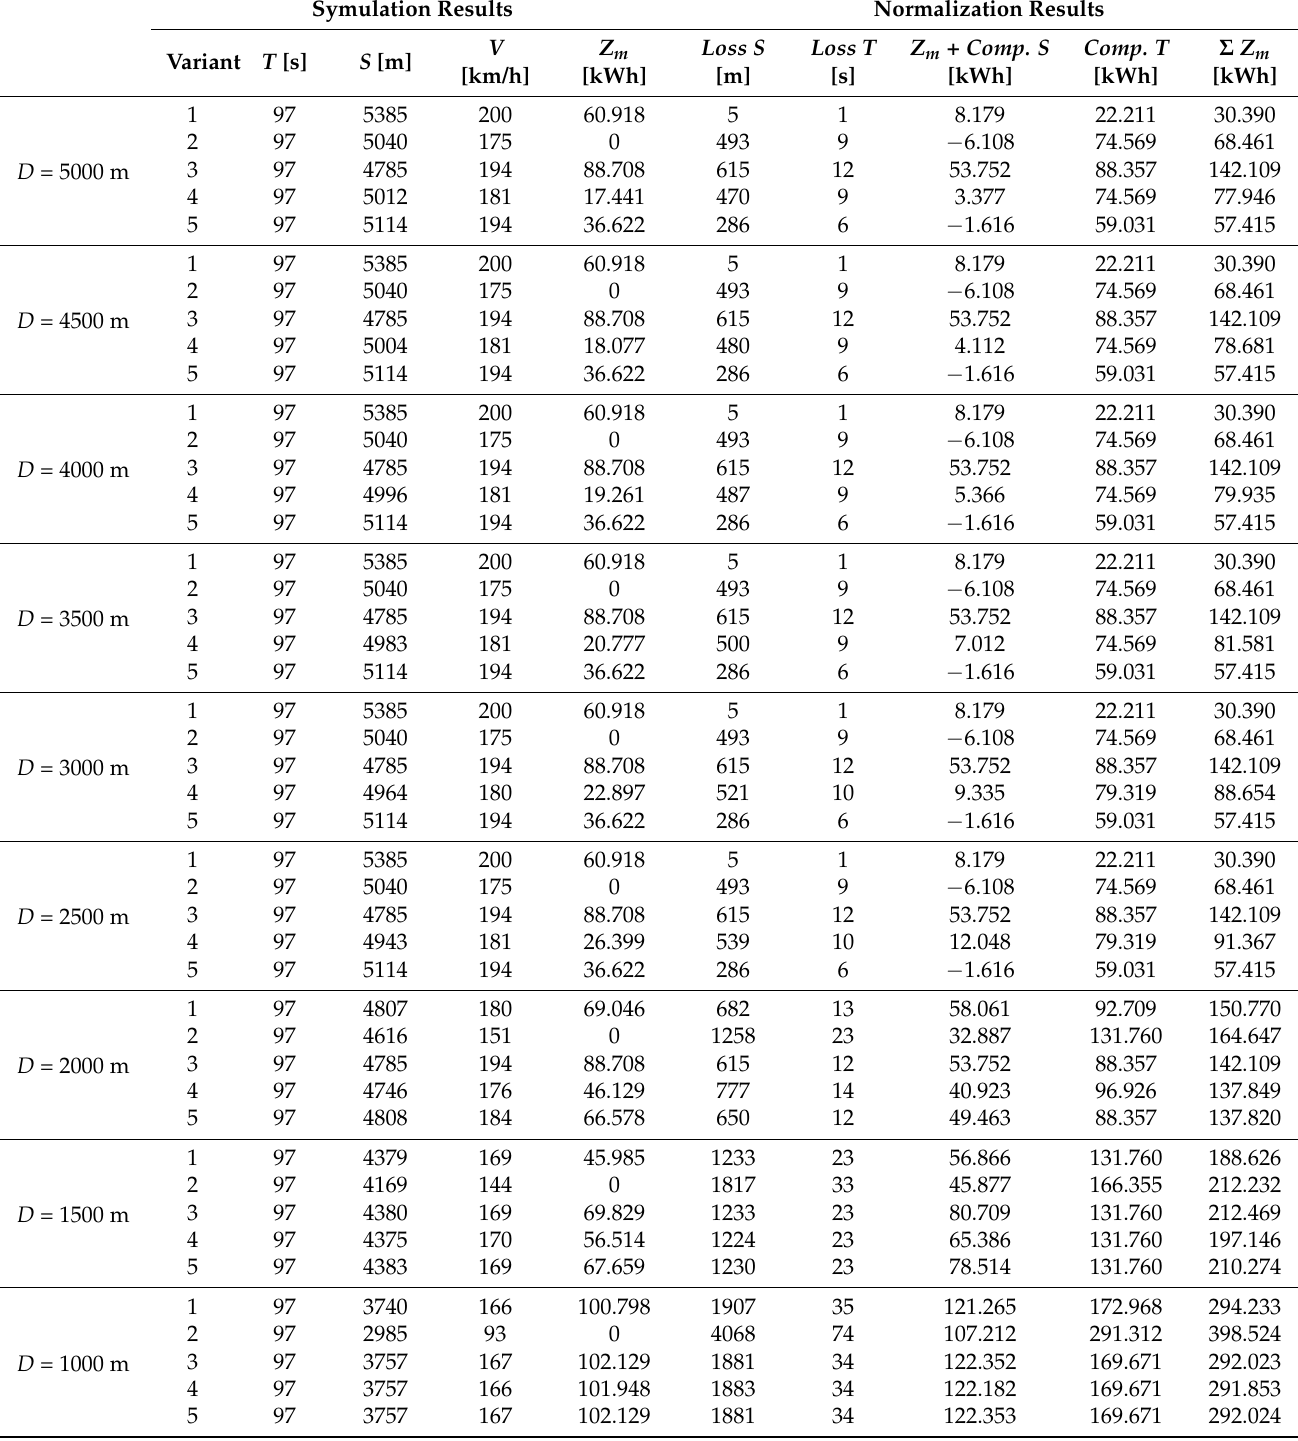
Table 2. Simulation results for context